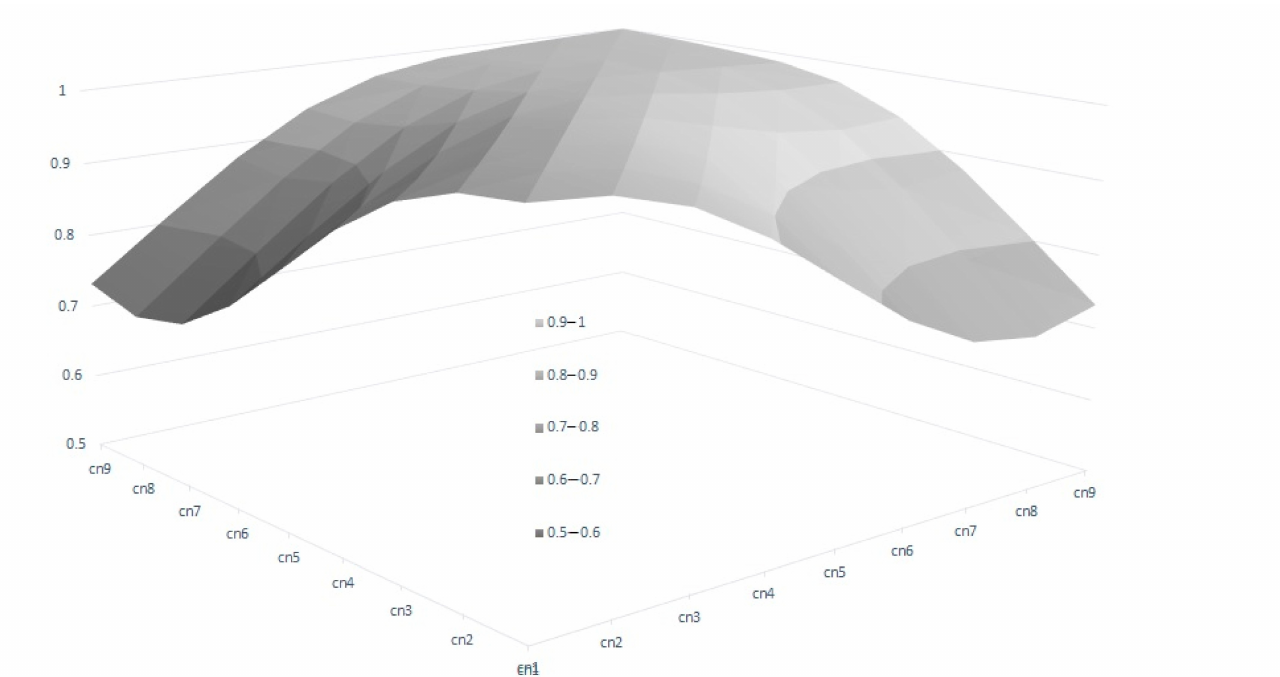
Figure 4. Genetic correlations of breeding value for reproductive efficiency between calvings, esti- mated by random regression genetic models.